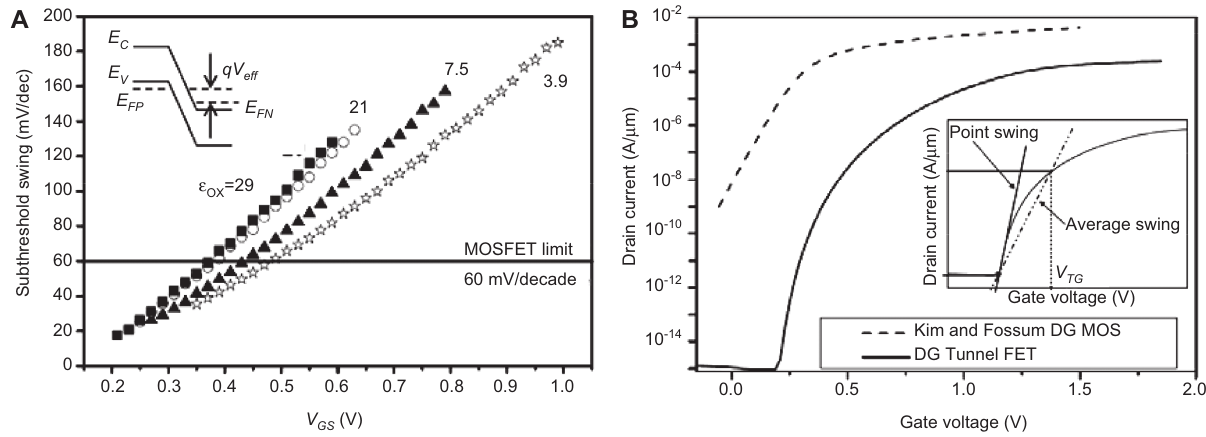
Figure 6 (A) Dependence of the TFET subthreshold slope on gate voltage for different gate oxide with different dielectric constants, from numerical simulation. Each curve goes up to the threshold voltage of that device. The points were generated by taking the slope value (d V /d(log I )) at each point on the I - V curves [2]. The inset shows the p + -n + tunnel-junction energy band diagram under a tunnel junc- GS DS DS GS tion bias V [27]. (B) Qualitative comparison of the transfer characteristics ( I eff